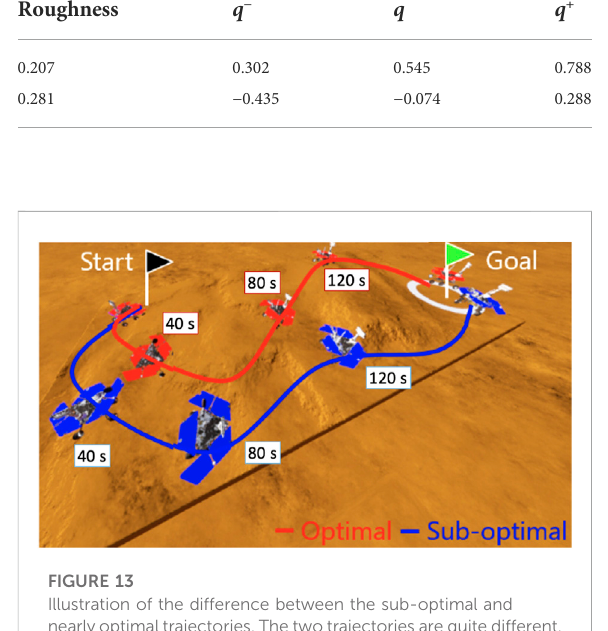
FIGURE 13 Illustration of the difference between the sub-optimal and nearly optimal trajectories. The two trajectories are quite different, but the costs are almost the same because of the rough and loose terrains.